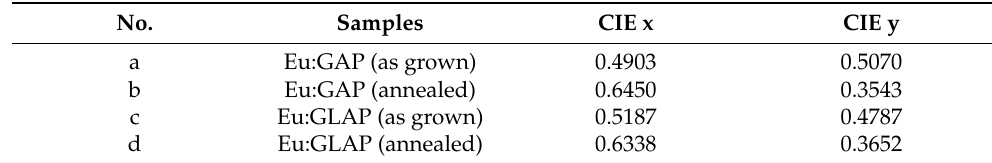
Table 1. Summarized color coordinates of Eu:GAP and Eu:GLAP crystals with or without the 1000 ◦ C for 4 h in Ar + 5% H 2 annealing process. No. Samples CIE x CIE y a Eu:GAP (as grown) 0.4903 0.5070 b Eu:GAP (annealed) 0.6450 0.3543 c Eu:GLAP (as grown) 0.5187 0.4787 d Eu:GLAP (annealed) 0.6338